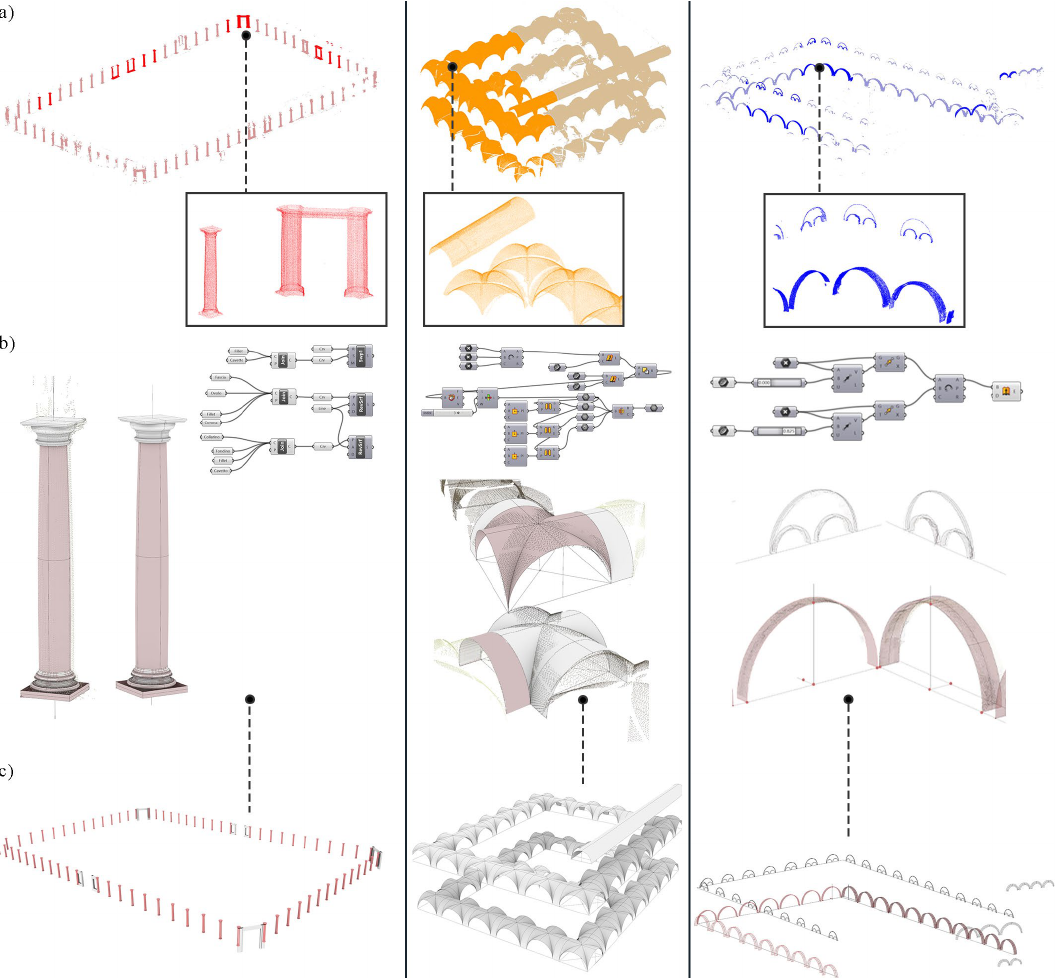
Figure 8. Examples of reconstruction of parametric components: original class (a), conceptual reference geometry (b) and propagation of the information to the whole class